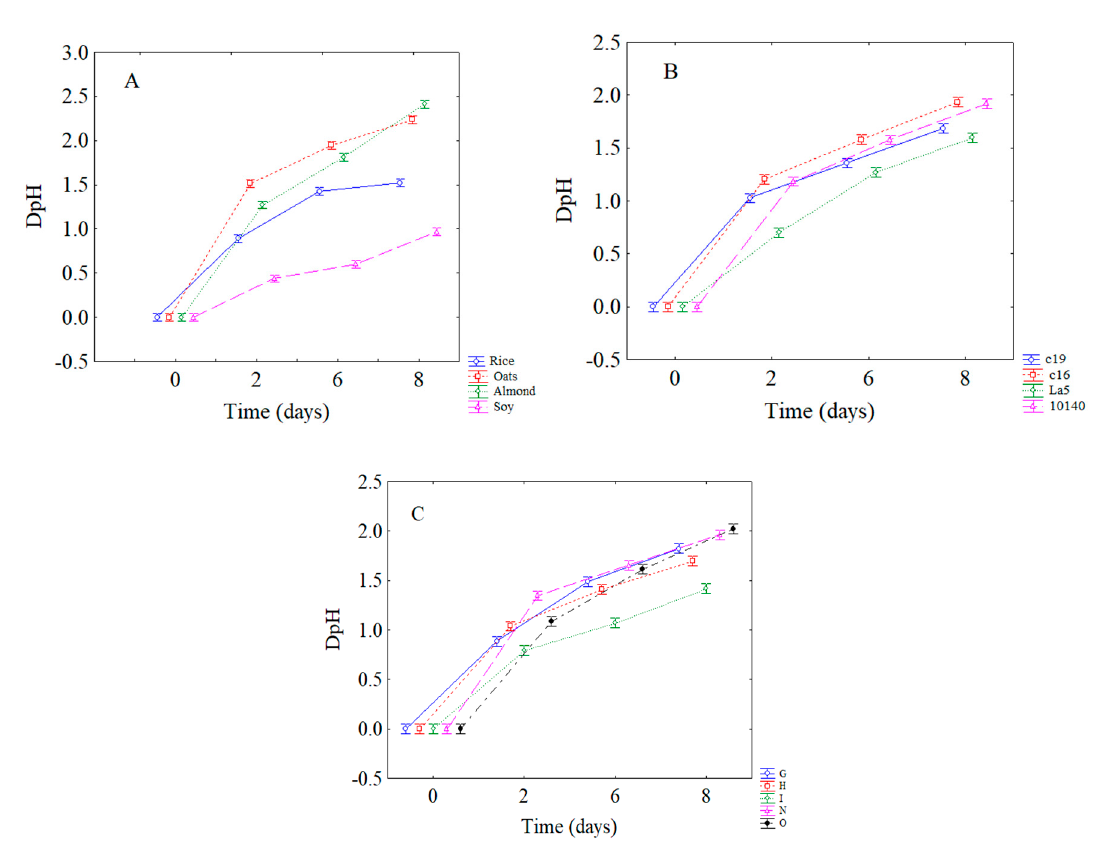
Figure 5. Decomposition of the statistical hypothesis for the interaction of time vs beverages ( A ), vs strains ( B ) and vs combinations ( C ) on acidification. Bars denote 95% confidence intervals. For the code of US treatments see Table 1.